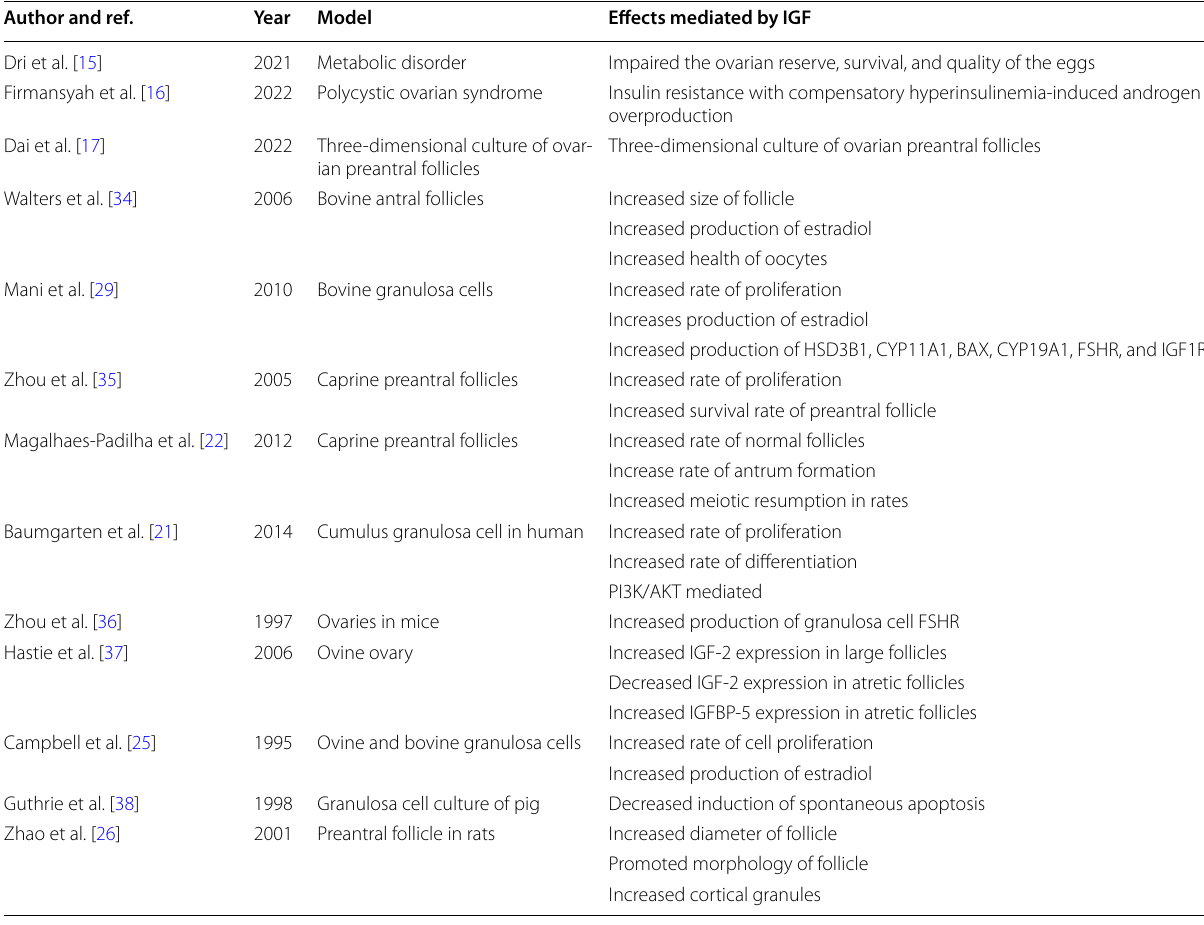
Table 1 The involvement of IGF in ovarian physiology and infertility Author and